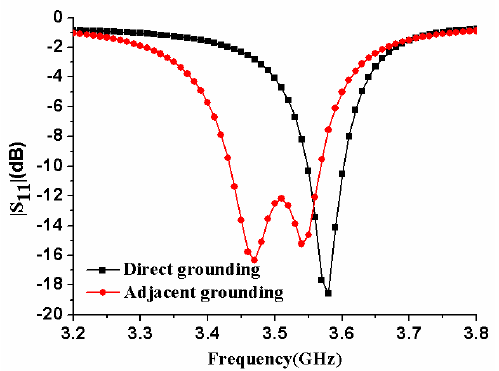
Figure 4. |S 11 | of the antenna element with different grounding methods.